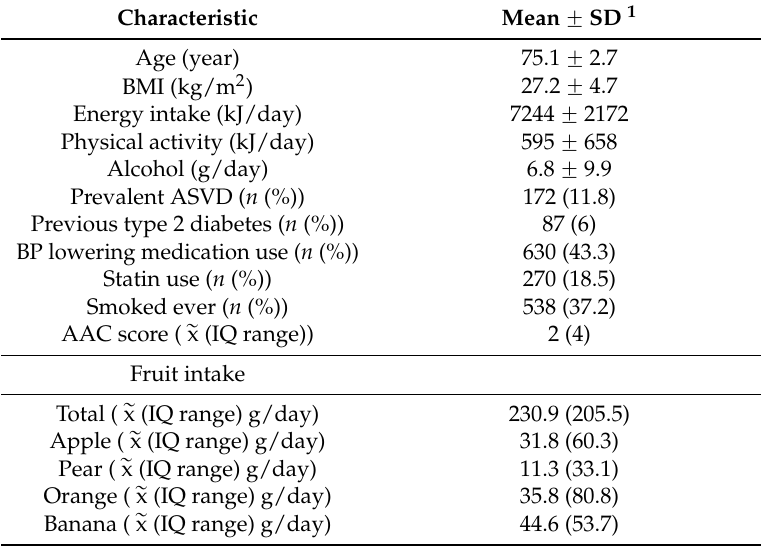
Table 1. Baseline